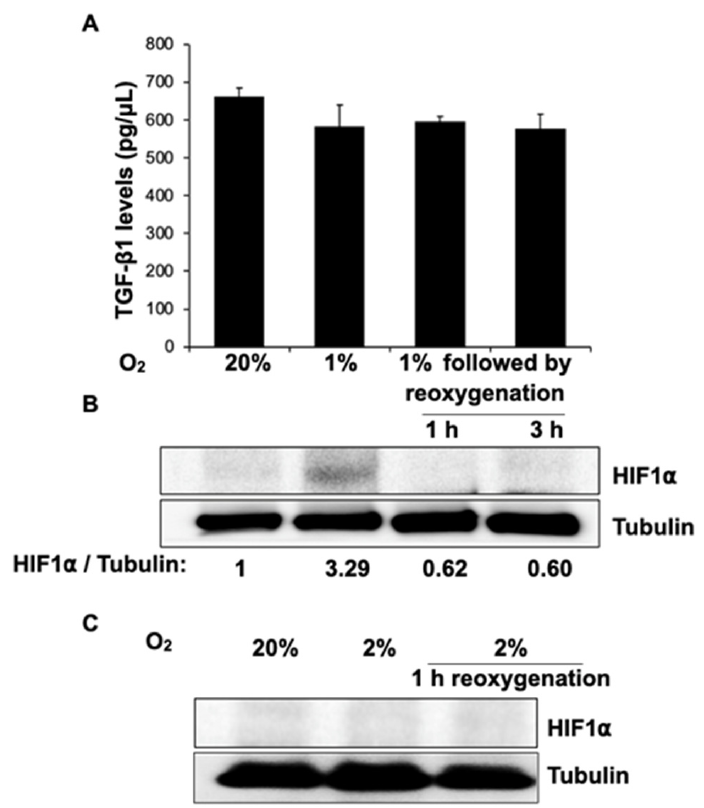
Figure 2. HIF-1a does not affect TGF-b1 secretion in human fibroblasts at 1% or 2% hypoxia or reoxygenation. Human fibroblasts were incubated at 20% O 2 , 1 % O 2 , or 1 % O 2 for 24 h, followed by reoxygenation for 1 or 3 h. ( A ) Equal amounts of cell culture supernatants from these were used to measure TGF- β 1 levels using ELISA. Error bars on the graph indicate standard deviation from the mean ( n = 2). ( B ) Equal amounts of cell lysates from the experiment in ( A ) were separated on an SDS-PAGE gel and probed for HIF1 α levels. Tubulin was probed as loading control (immunoblot below). While HIF1 α increased with hypoxia and decreased following reoxygenation, no change was observed in TGF- β 1 levels. ( C ) Similarly, fibroblasts were incubated at 20% O 2 , 2 % O 2 , or 2 % O 2 for 24 h, followed by reoxygenation for 1 h, and probed for HIF1 α levels. HIF1 α was not present at 2% hypoxia.